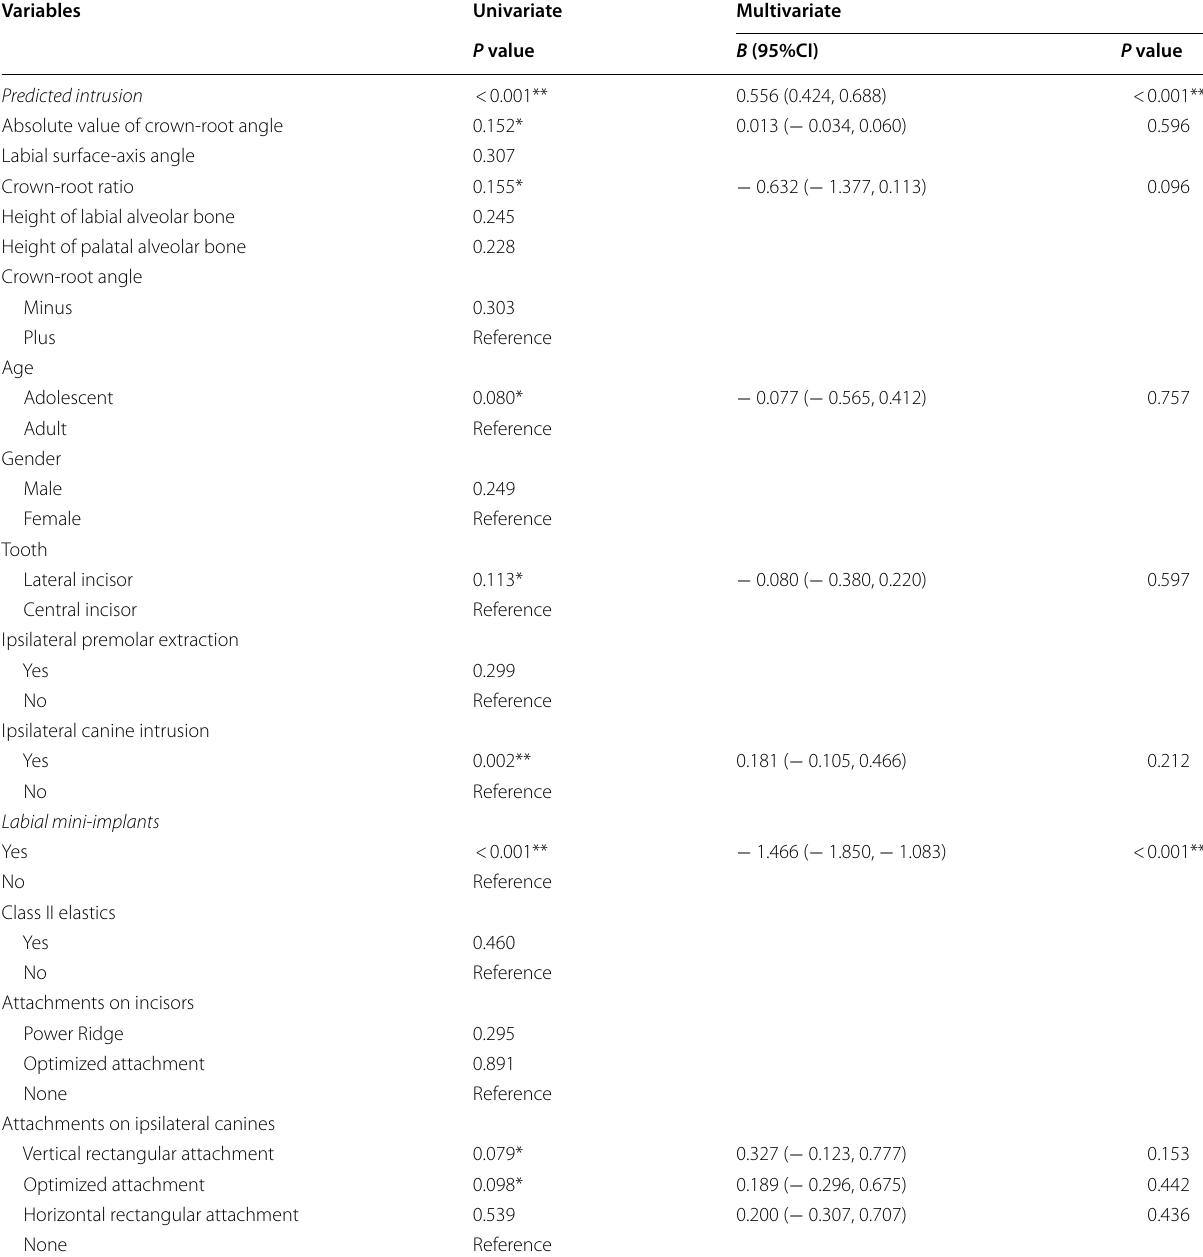
Table 6 Univariate and multivariate linear regression analyses for DPA of upper incisor